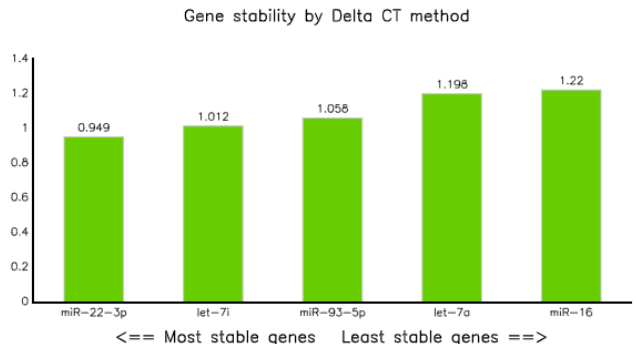
Figure 5. Graph showing stability of selected miRNAs analyzed by Best Keeper. Table 6. Average standard deviation result of selected miRNAs calculated by Best Keeper software.